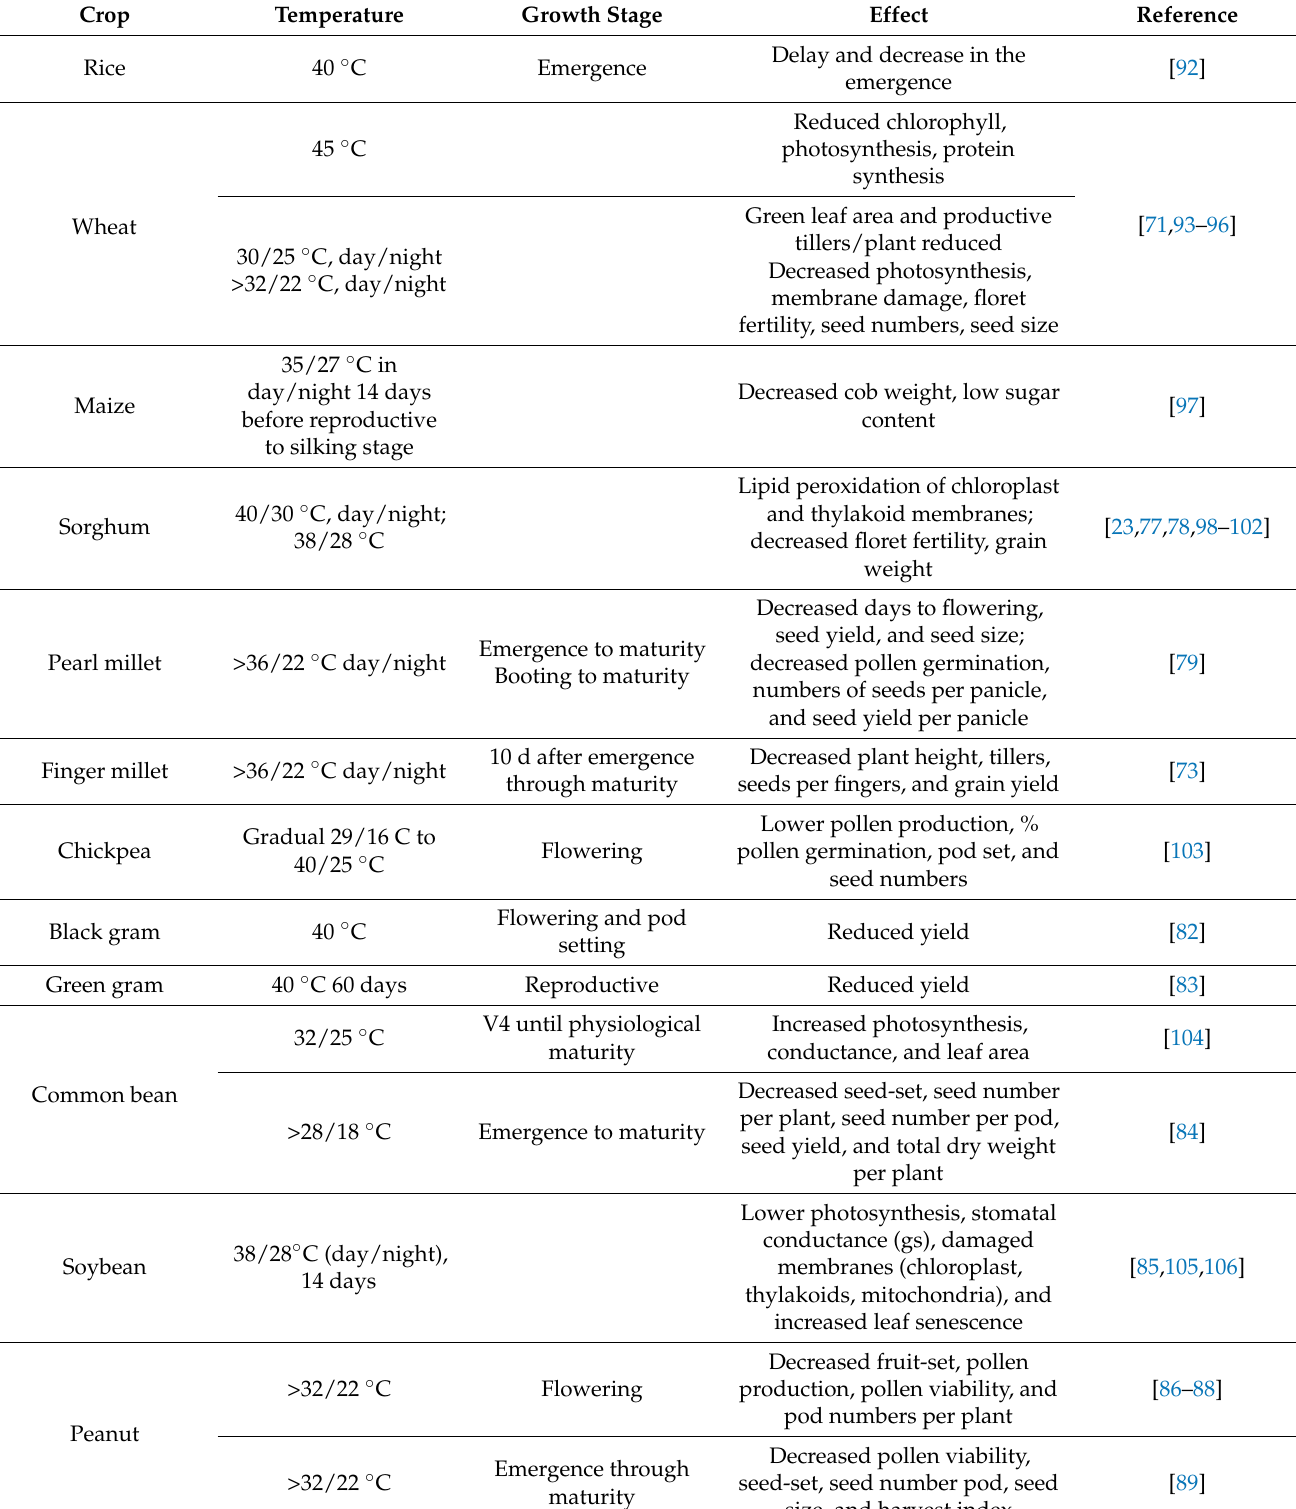
Table 3. Effects of high temperature stress on different crop